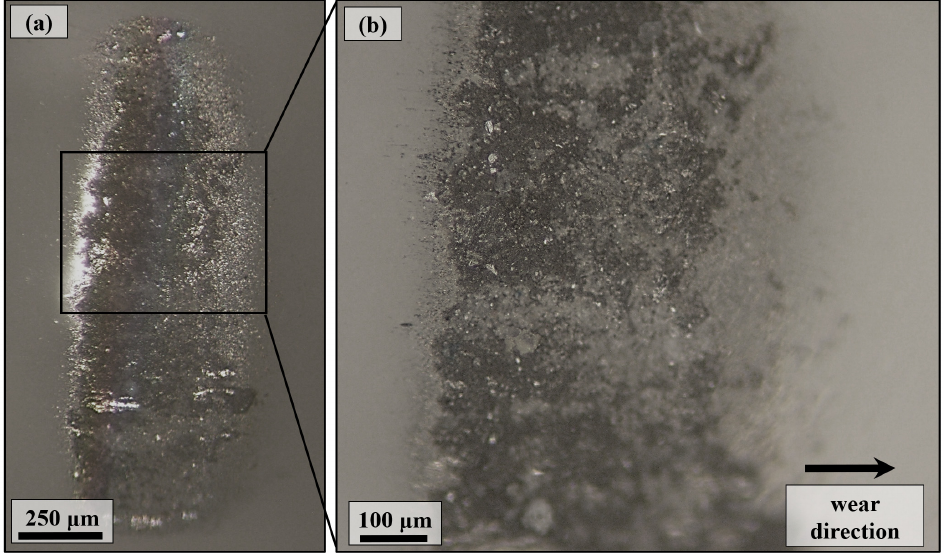
Figure 13. Optical microscope image of worn surface of the alumina ball at a sliding distance of 600 m at low magnification ( a ) and at high magnification ( b ), indicating the transfer of material (Cp-Ti) to the alumina ball while the ball was still intact.